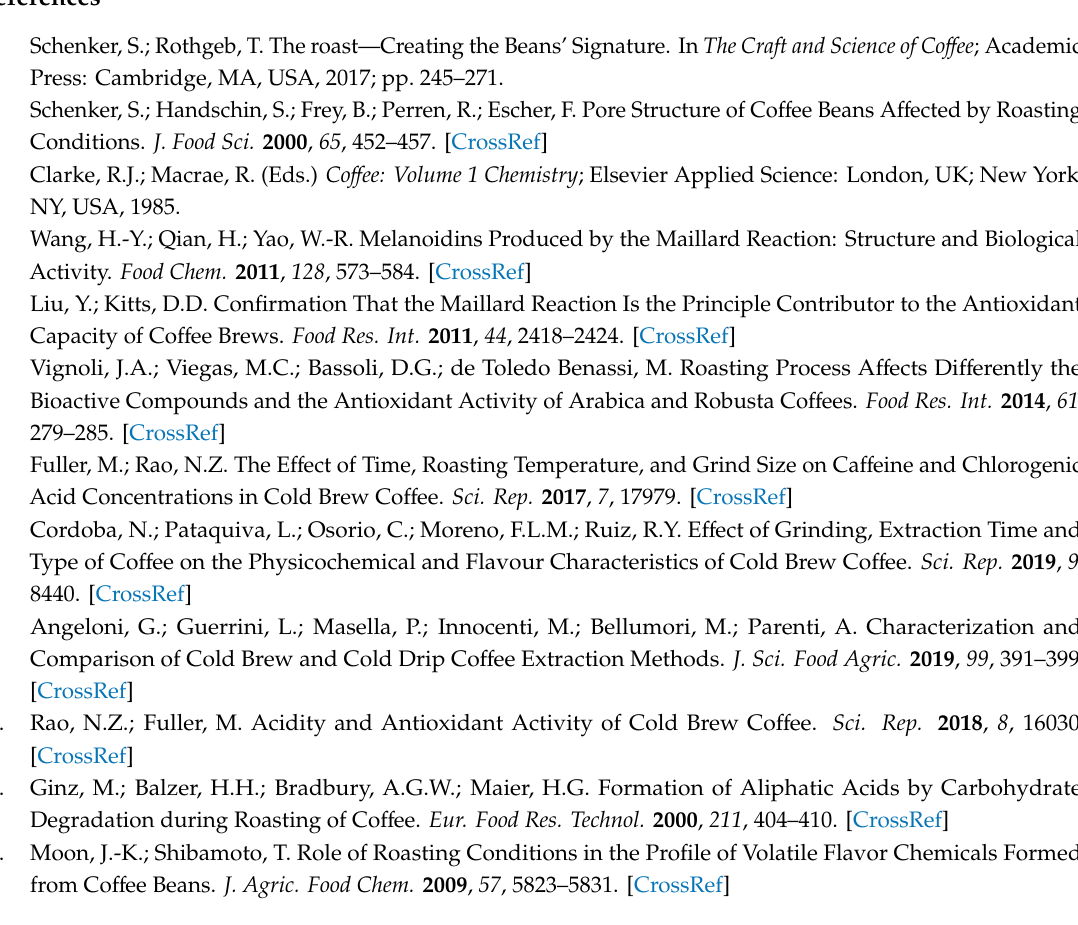
Table S1: ANOVA Summary Table for pH, Table S2: ANOVA Summary Table for Total Titratable Acidity (TTA), Table S3: ANOVA Summary Table for Total Dissolved Solids (TDS), Table S4: ANOVA Summary Table for Browned Compounds, Table S5: ANOVA Summary Table for Ca ff eine, Table S6: ANOVA Summary Table for Total CQA, Table S7: ANOVA Summary Table for Total Antioxidant Activities (TAC), Table S8: ANOVA Summary Table for 5-CQA, Table S9: ANOVA Summary Table for 4-CQA, Table S10: ANOVA Summary Table for